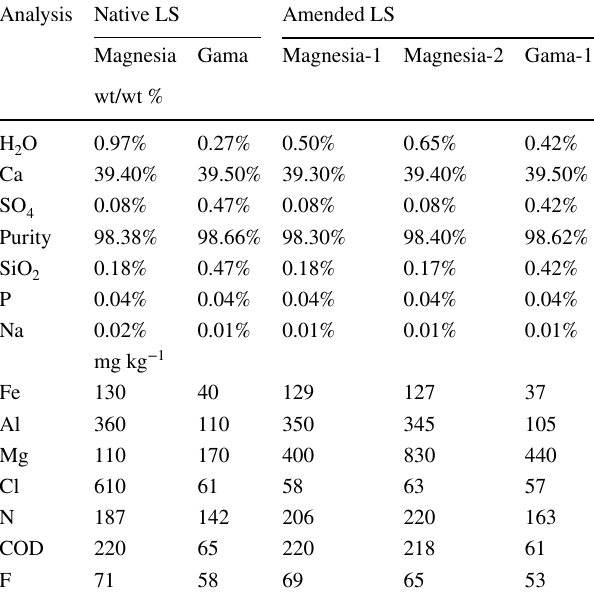
Table 1 Results of chemical analysis of native and amended LS sub-